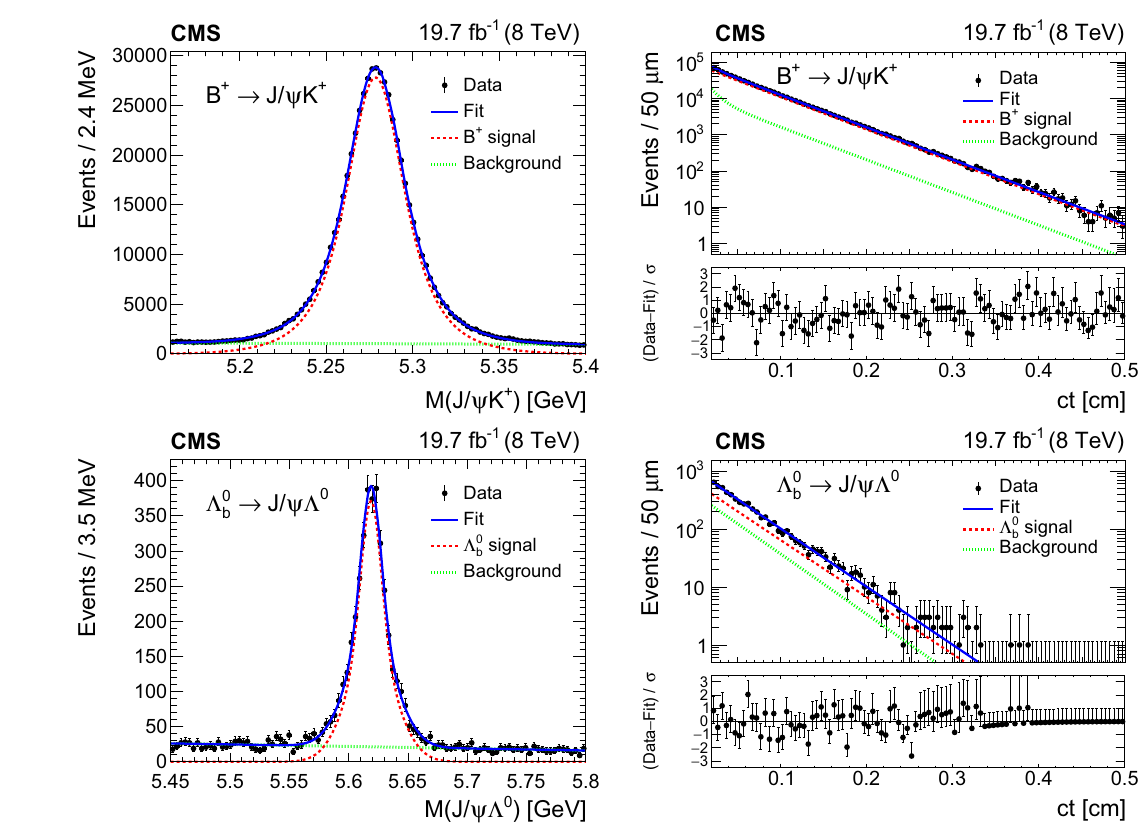
of the figures on the right show the difference between the observed data and the fit divided by the data uncertainty. The vertical bars on